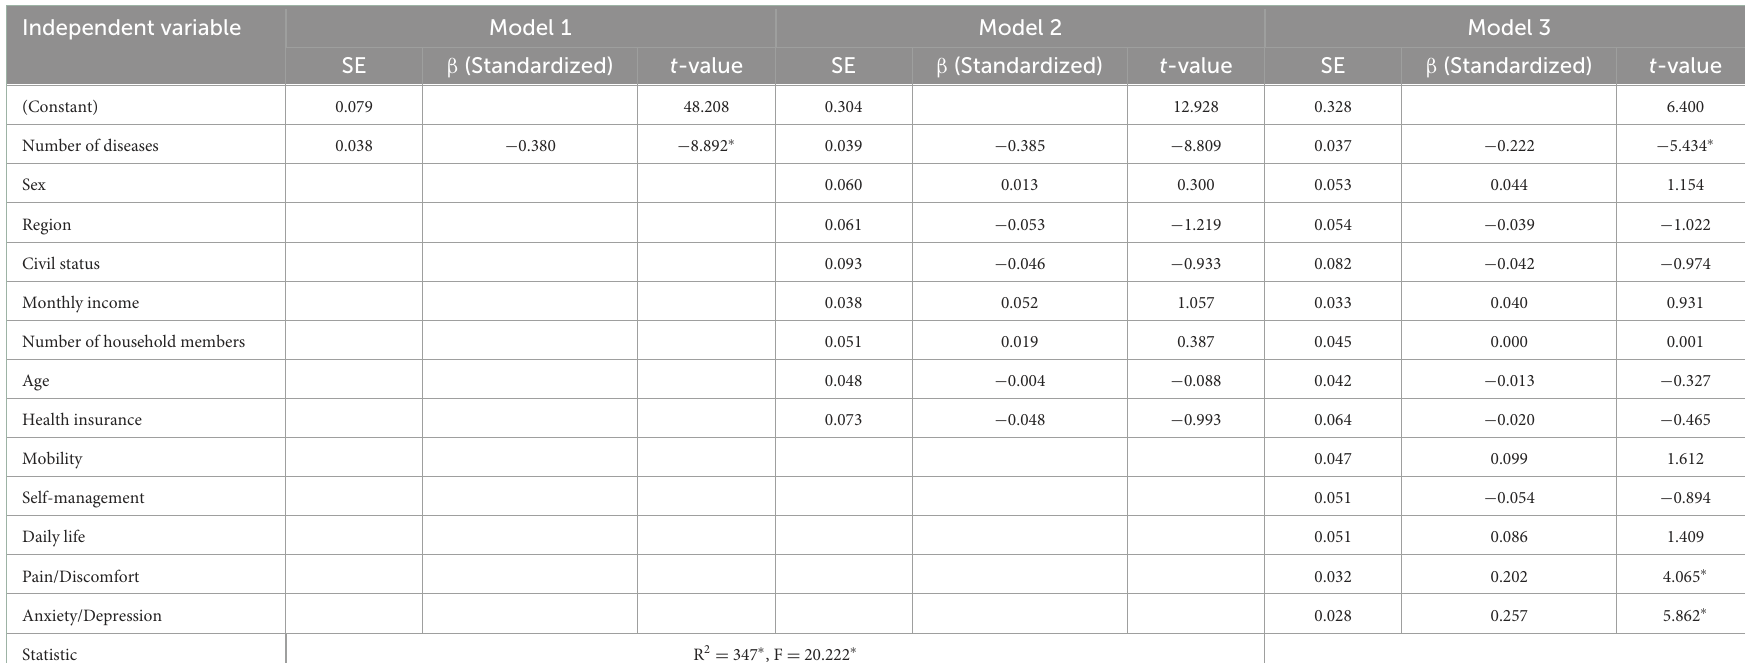
TABLE 7 Factors influencing health satisfaction (Model